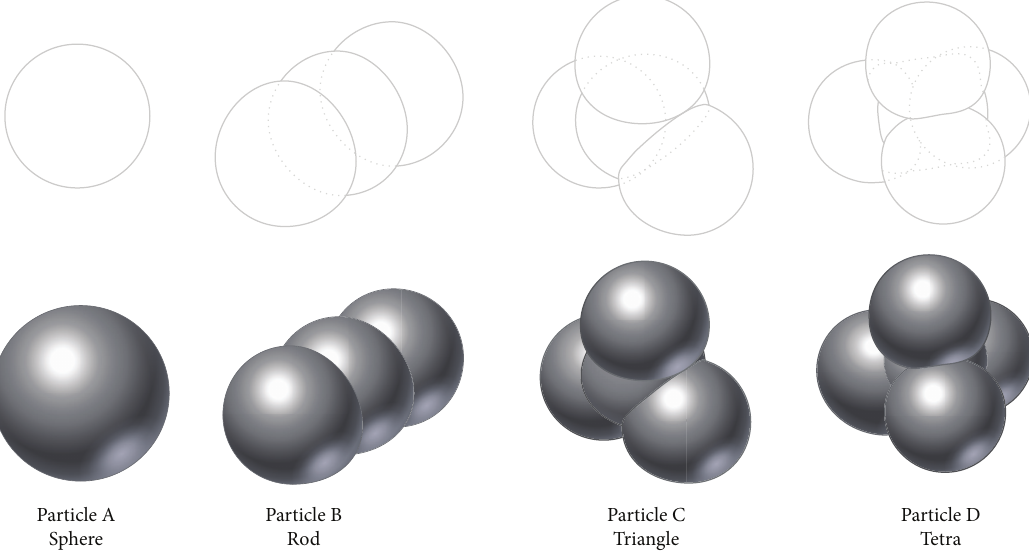
Figure 2: Types of simulated